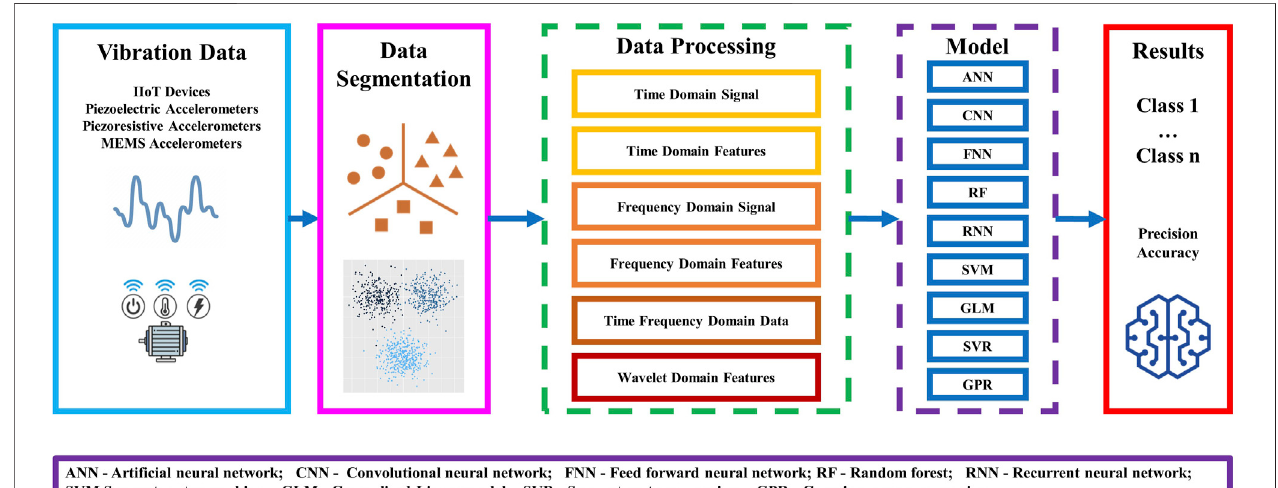
FIGURE 5 | Signal data analysis, engineering processing and AI-based model building fl ow.